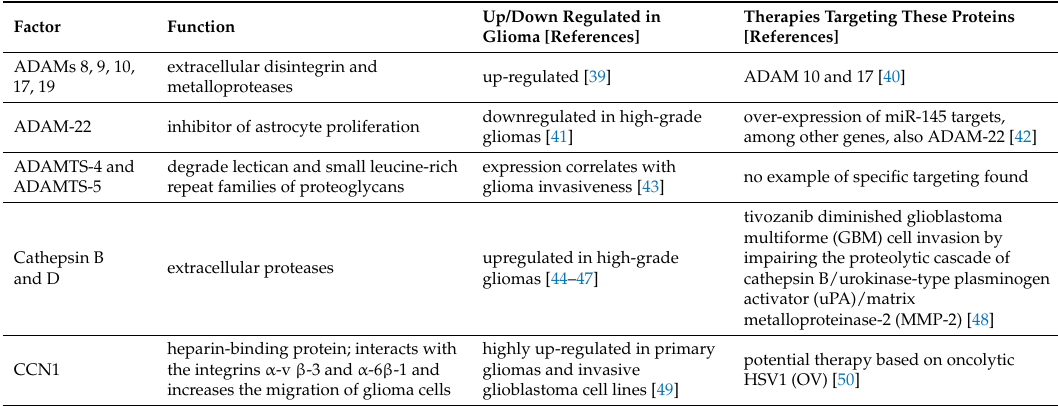
Table 1. Examples of extracellular matrix ECM components and ECM modifying enzymes that have been reported to be up/down-regulated in gliomas. In the last column, a few examples of therapies targeting these proteins are